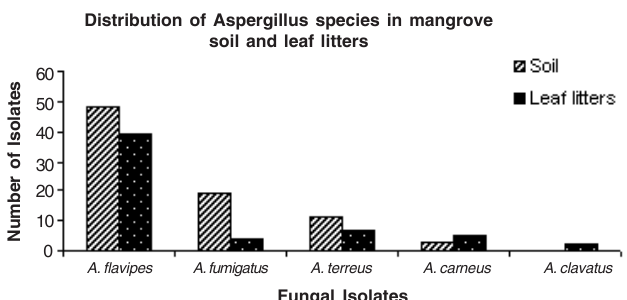
Figure 1. Total number of Aspergillus spp. isolated from mangrove soil and leaf